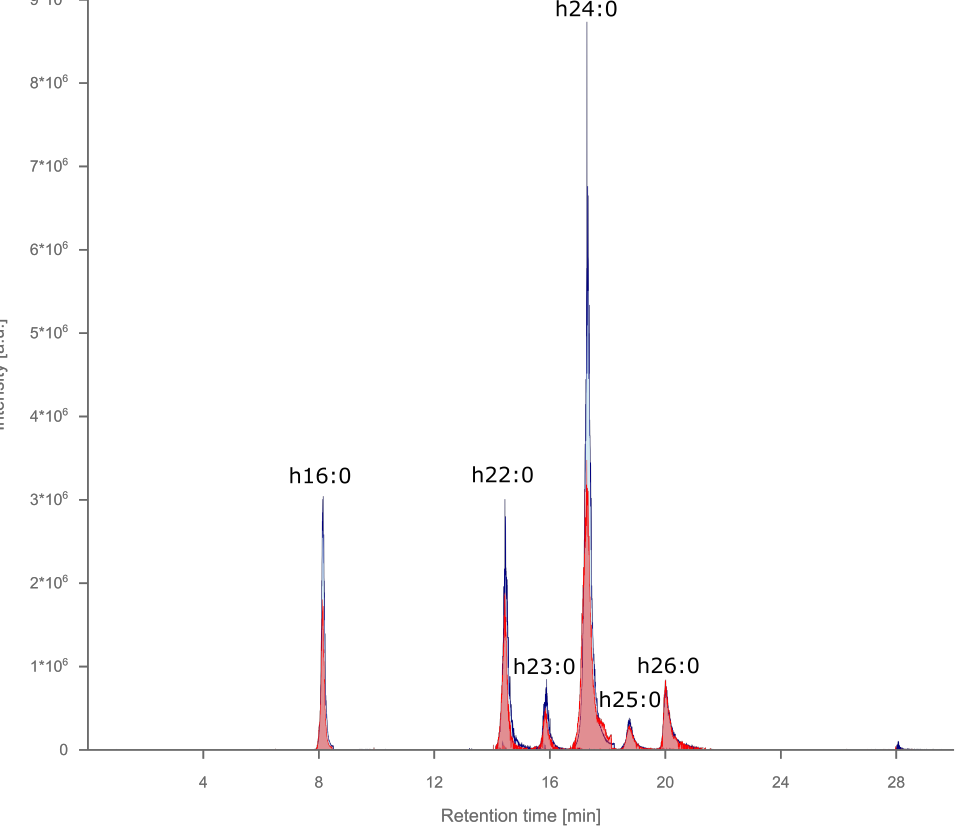
Figure 1. Extracted ion chromatogram of glycosyl inositol phospho ceramides (GIPCs) in salad samples analyzed by RP-HRMS / MS analysis using ddMS2 in positive (red) and negative (blue) ion modes. Assigned GIPCs belong to the Hex-HexA-IPC series with a t18:1 long-chain base (LCB) and varying chain length of the hydroxylated saturated fatty acids. Retention times coincided in positive and negative ion modes. Increasing carbon numbers result in belated